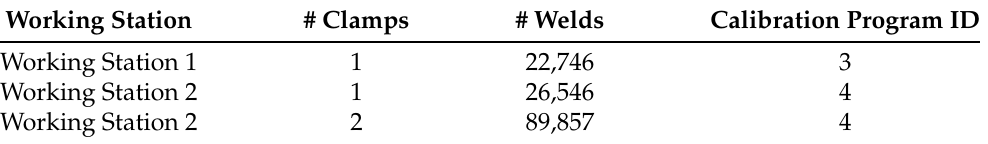
Table 2. Dataset Overview.